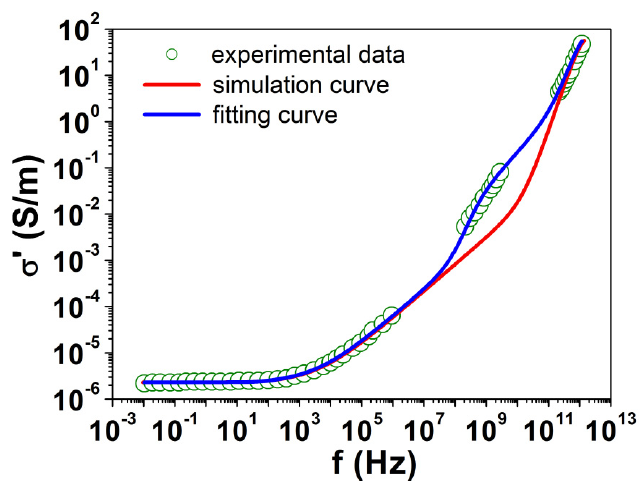
Figure 2. Experimental data of the AC conductivity as a function of frequency of poly(p-phenylenediamine) (PPDA) (Data were taken from literature [45]). The blue line is the best fitting according to Equation (9) with k = m = 1 and two HN terms, by keeping constant the DC conductivity value, σ ο = 2.3 × 10 − 6 S/m. The fitting parameters’ values are: α 1 = 1, β 1 = 0.42, Δε 1 = 114.5, f HN1 = ω ΗΝ 1 /2 π = 49.0 (Hz), a 2 = 1, β 2 = 0.28, Δε 2 = 2.1, f HN2 = ω ΗΝ 2 /2 π = 410 (MHz), γ /2 π = 2.0 × 10 12 (Hz), A /(2 π ) 2 = 4.5 × 10 24 (Hz 2 ) and ω ο /2 π = 3.9 × 10 12 (Hz). The red line is a simulation curve according to Equation (9) with the previous parameter values and without the second HN contri- bution.